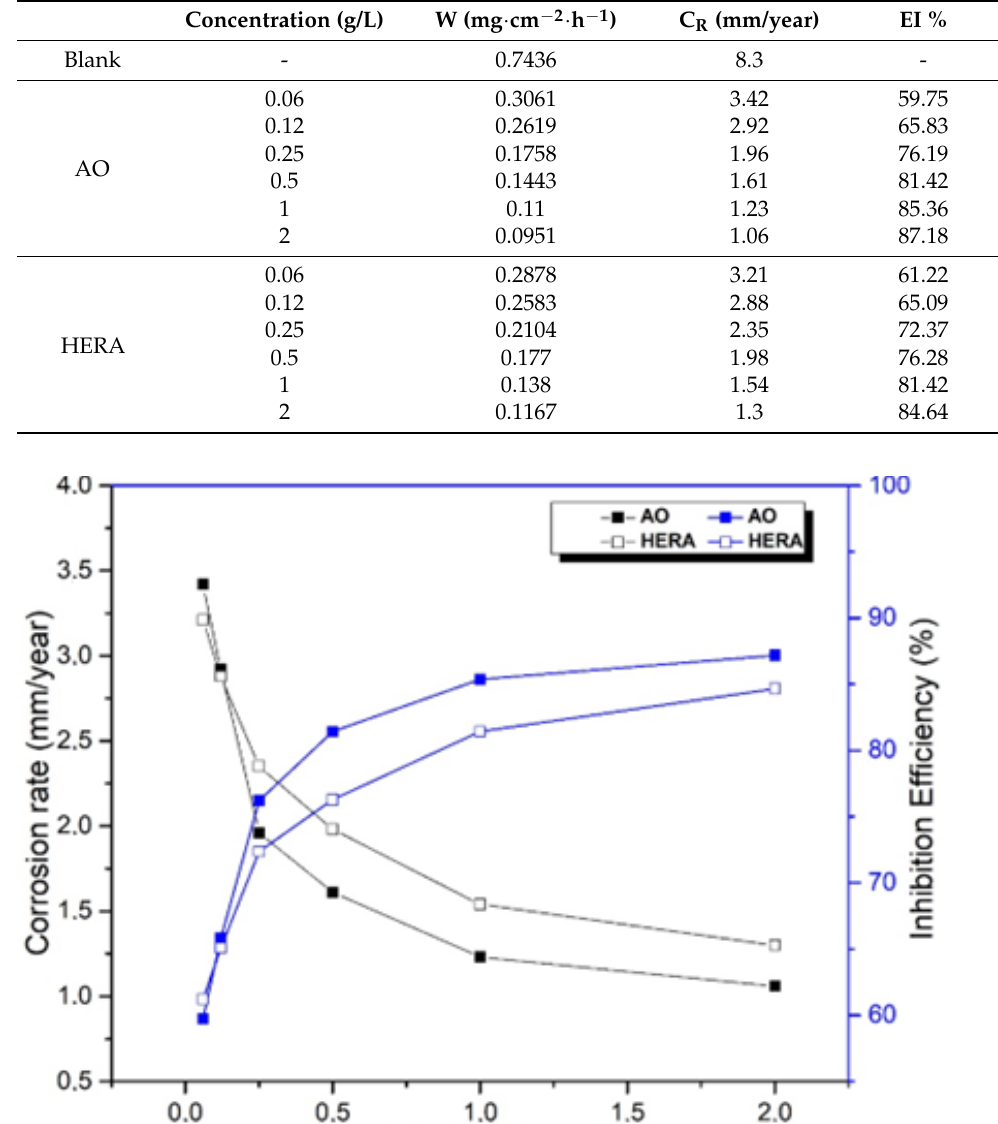
Table 2. AO and HERA concentration effect on mild steel corrosion rate and corrosion inhibition efficiency.